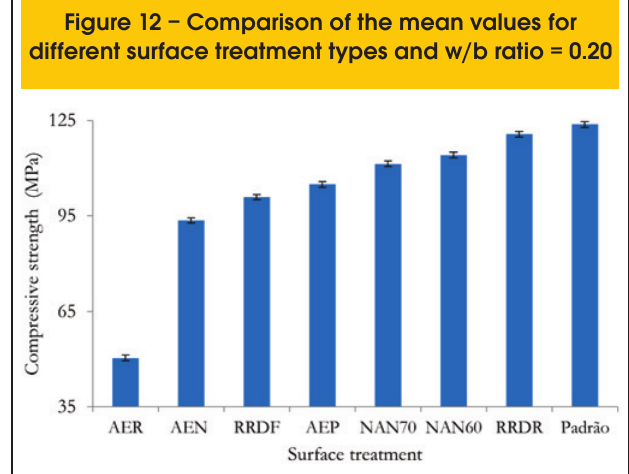
Figure 11 – Comparison of the mean values for different surface treatment types and w/b ratio = 0.27